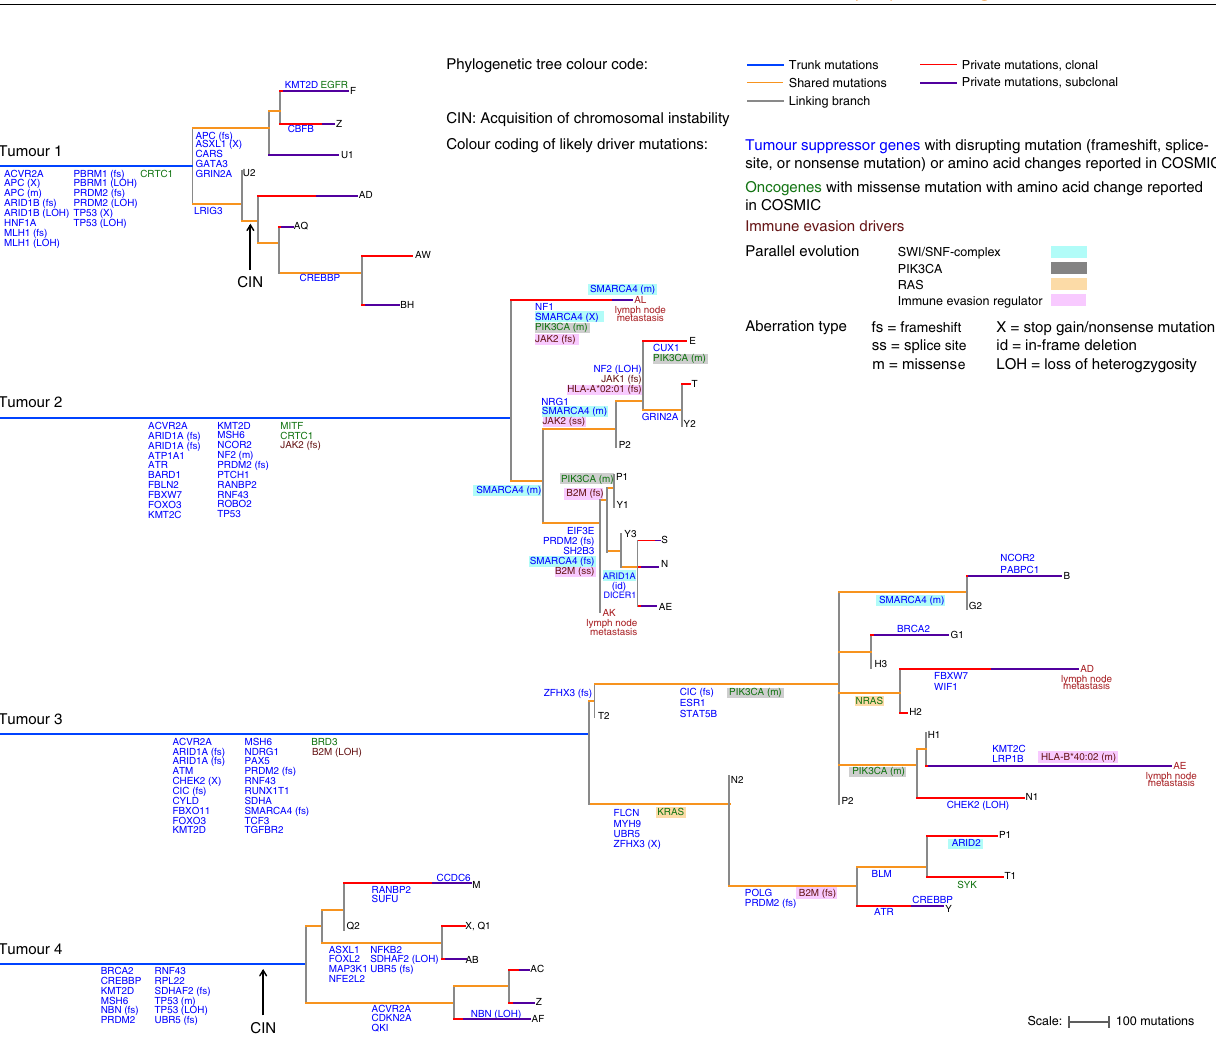
Fig. 3 Tumour phylogenetic trees. Trees were reconstructed from non-silent and synonymous mutations and trunk and branch lengths are proportional to the number of mutations acquired. Trees are rooted at the germline DNA sequence, determined by exome sequencing of DNA from tumour adjacent normal tissue. Subclones that de fi ne the tips of the tree are labelled with the tumour region in which they were identi fi ed. Numbers were added where several subclones were identi fi ed by the phylogenetic deconvolution algorithm within a tumour region, with 1 de fi ning the largest intra-regional subclone and 2, 3 increasingly smaller subclones. Private mutations were furthermore split into those that were clonal in the analysed region (present in >0.7 of the cancer cell fraction in that region) and those that were subclonal (present in ≤ 0.7 of the cancer cell fraction). Likely driver mutations and relevant loss of heterozygosity (LOH) events were mapped onto the branch of the trees where they likely occurred. Genes affected by more than one genetic aberration within a tumour are labelled with the genetic aberration type that occurred. Arrows labelled ‘ CIN ’ indicate the likely onset of chromosomal